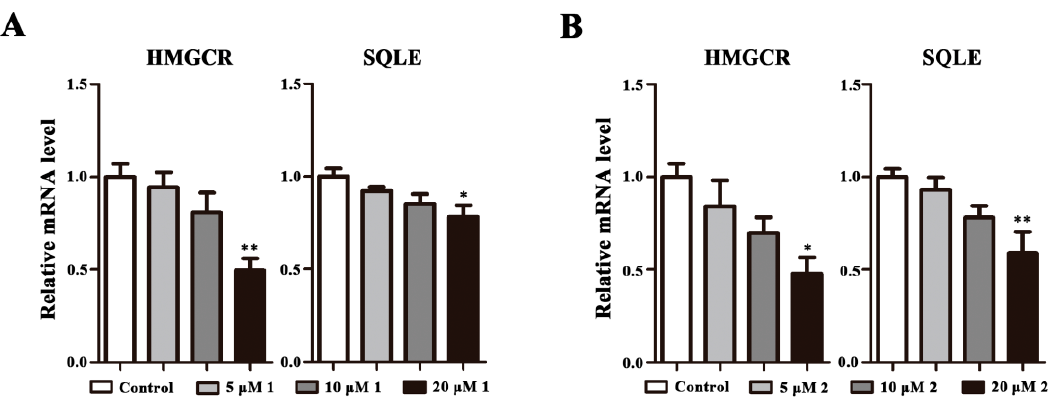
Figure 4. 1 and 2 stimulate the expression of HMGCR and SQLE genes. HepG2 cells were treated with 1 or 2 at 5, 10, and 20 µ M for 48 h. Target mRNA levels are expressed relative to those in control by qPCR methods. All data are expressed as mean ± SEM ( n = 3) and analyzed by ANOVA with Bonferroni’s test. * p < 0.05, ** p < 0.01 vs control.